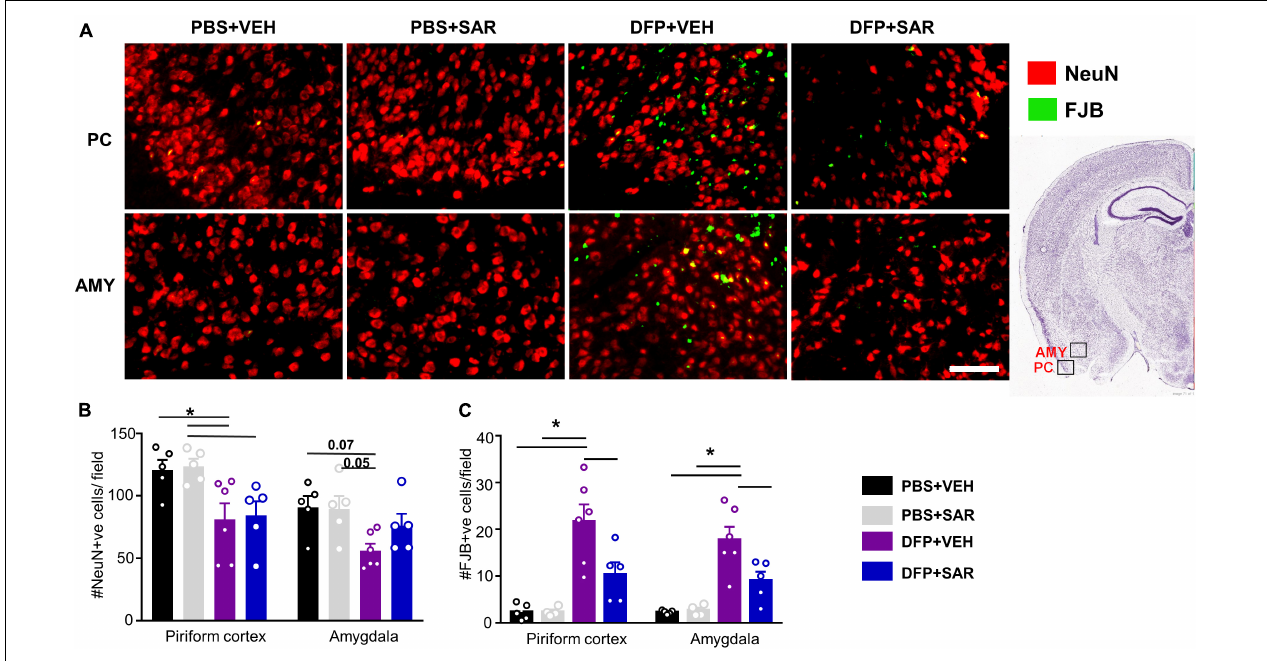
FIGURE 10 | Saracatinib (SAR) mitigated DFP-induced neurodegeneration in AMY. (A) Representative images of NeuN + FJB staining from PC and AMY are shown. (B) DFP, regardless of treatment with vehicle or SAR, led to a significant reduction in NeuN positive cells in the PC. However, in the AMY the changes were not significant though there was an increase of NeuN positive cells in SAR compared to VEH (mixed measures ANOVA, n = 5-6). (C) FJB staining revealed a significant increase of degenerating neurons in DFP + VEH and significant mitigation by SAR (mixed measures ANOVA, n = 5-6). Error bars indicate standard error of the mean. Mixed measures ANOVA, n = 4-6. * p < 0.05. Field = 0.14 mm 2 Atlas Image credit: Allen Institute, United